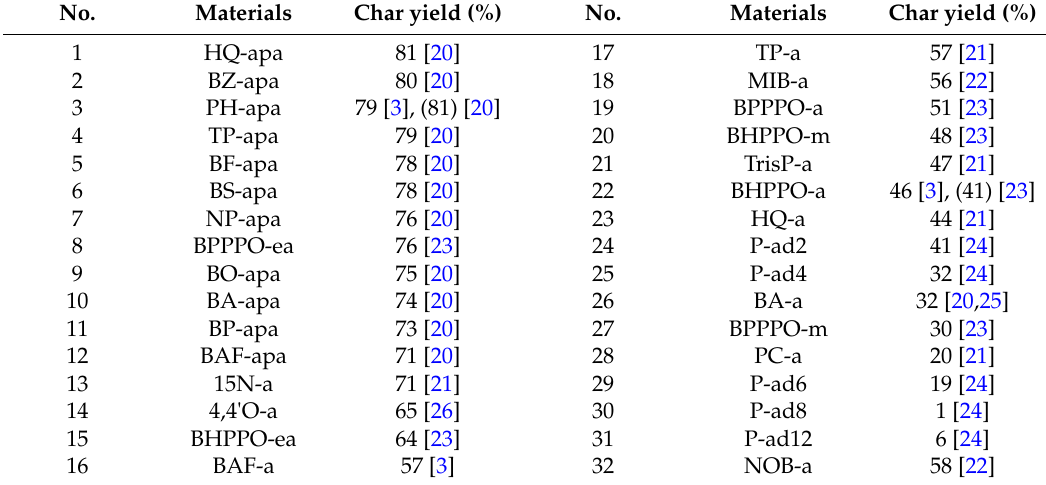
Table 1. List of % char yield of thirty-three benzoxazine monomers (the training set). The definition of the abbreviation used for each benzoxazine are given in the Abbreviations at the end of the